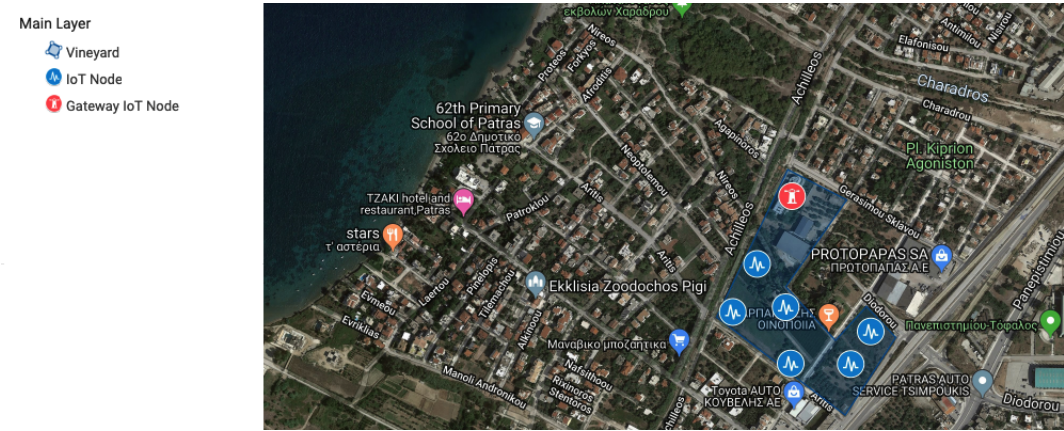
Figure 23. Precision Agriculture Use